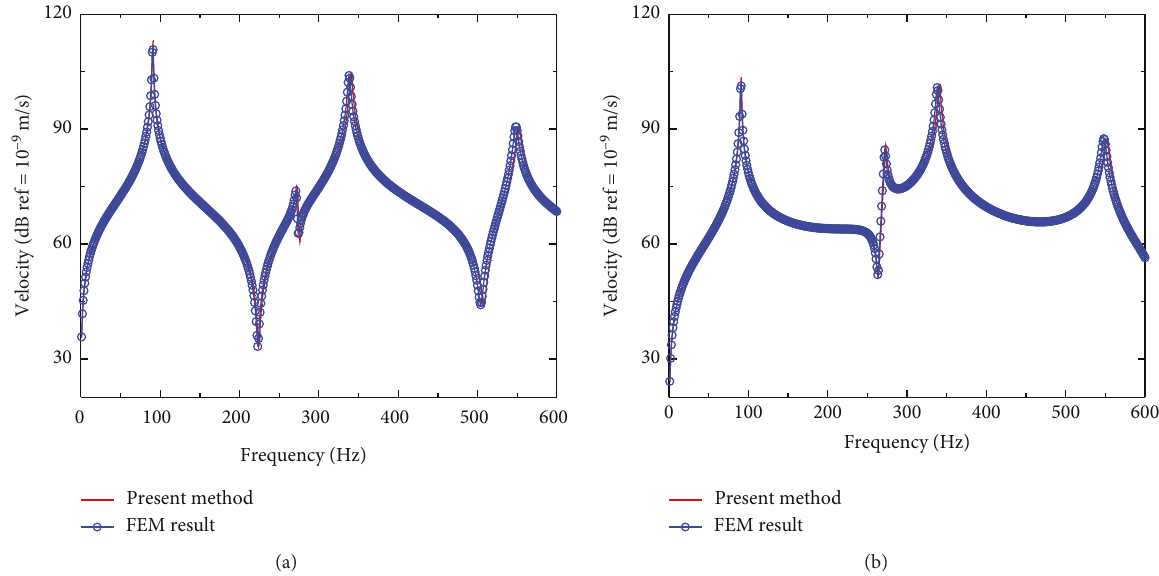
Figure 6: Comparison of velocity response for square plate with one beam located at its diagonal line under local uniform pressure ( p (a) Point C (0.5m, 0.5m). (b) Point D (0.25 m,